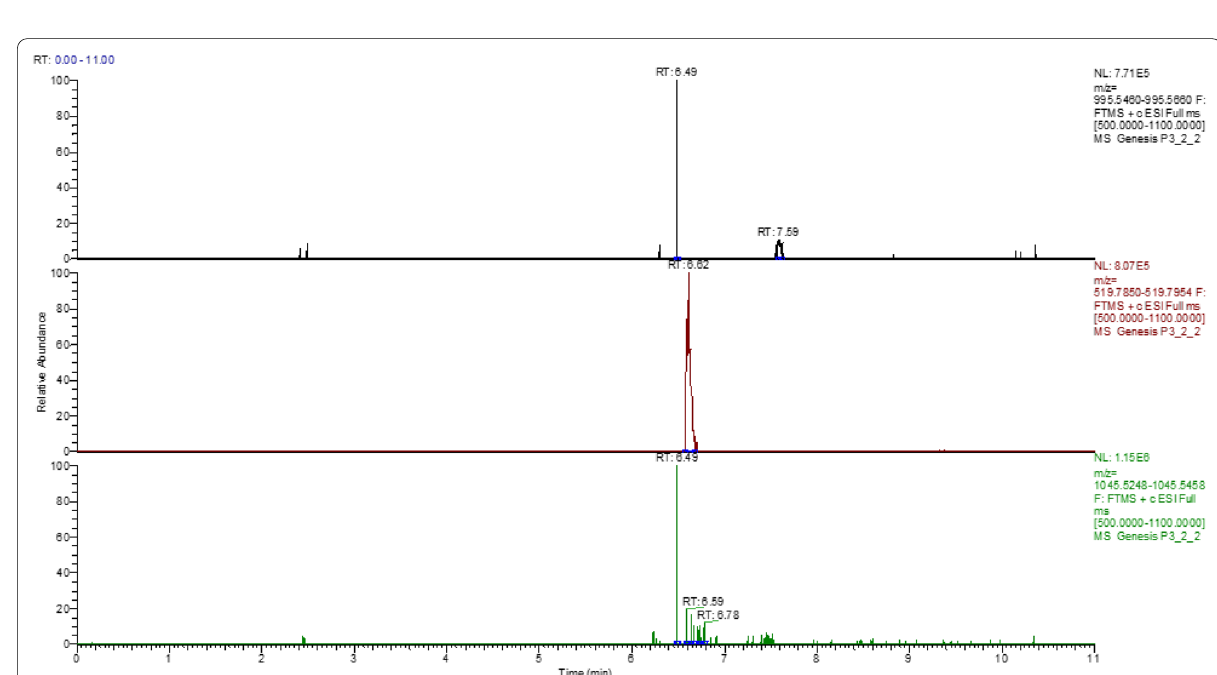
Fig. 5 Chromatogram of farmed mussel in the area of Imathia. Retention time of microcystin-LR is 7.9 min and of microcystin-RR 6.61